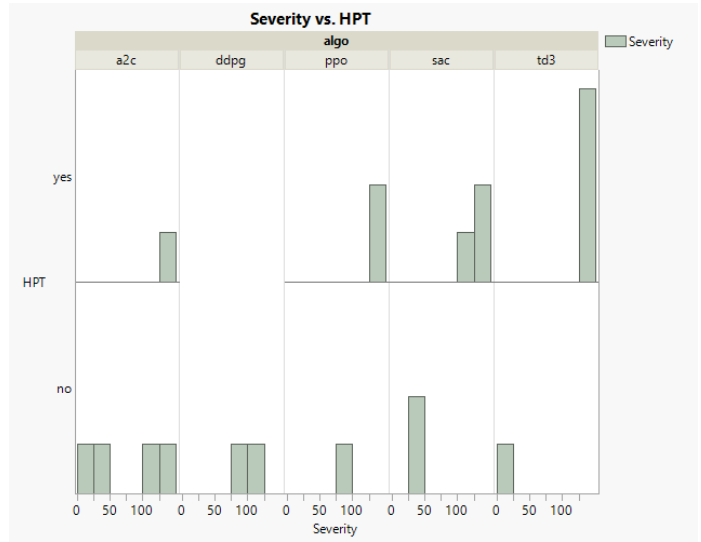
Figure A1. Severity level of found faults on the RL algorithms when we use default hyperparameters and when we use tuned hyperparameters on ACC.